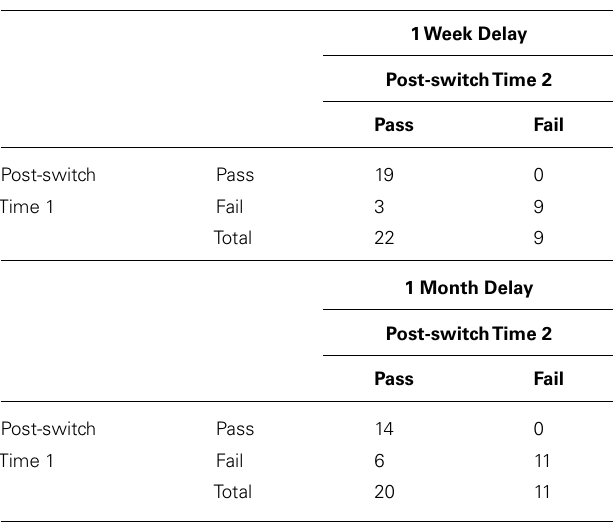
Table 1 | Pass–fail rates for the first and second post-switch phases for each condition on the Dimensional Change Card Sort